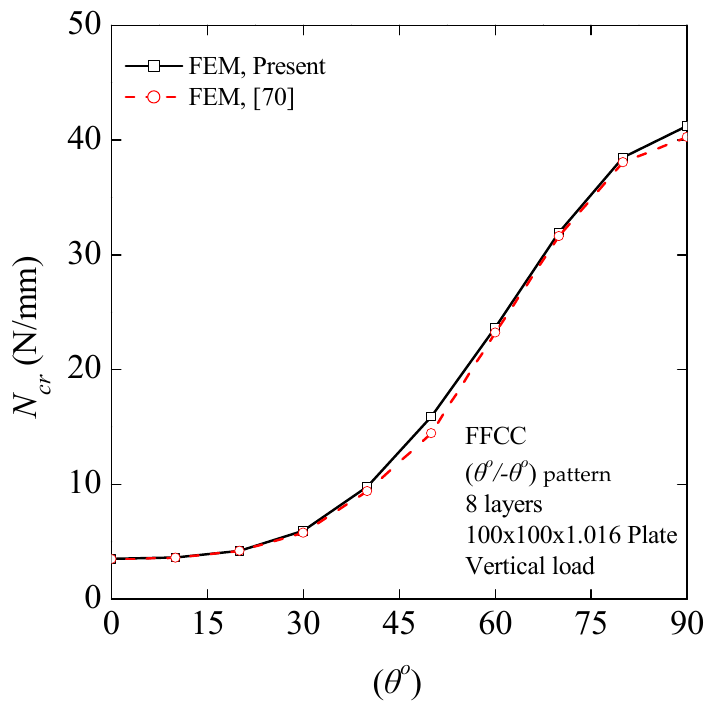
Figure 5. Critical buckling load as a function of fiber orientation angle ( θ ο ). The diagram shows the effect of fiber orientation angle on the critical buckling load by changing the ( θ °/ − θ °) pattern. To ensure the validity of the process, identical material properties were employed.